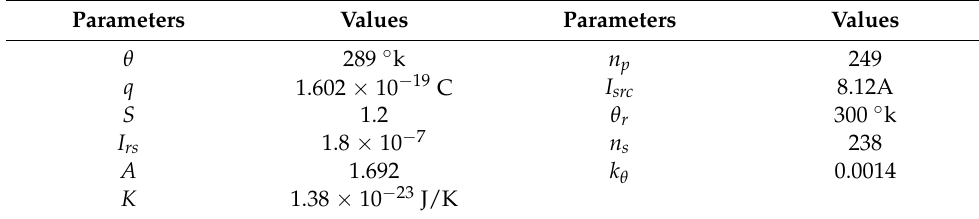
Table 4. Parameters of the PV system.